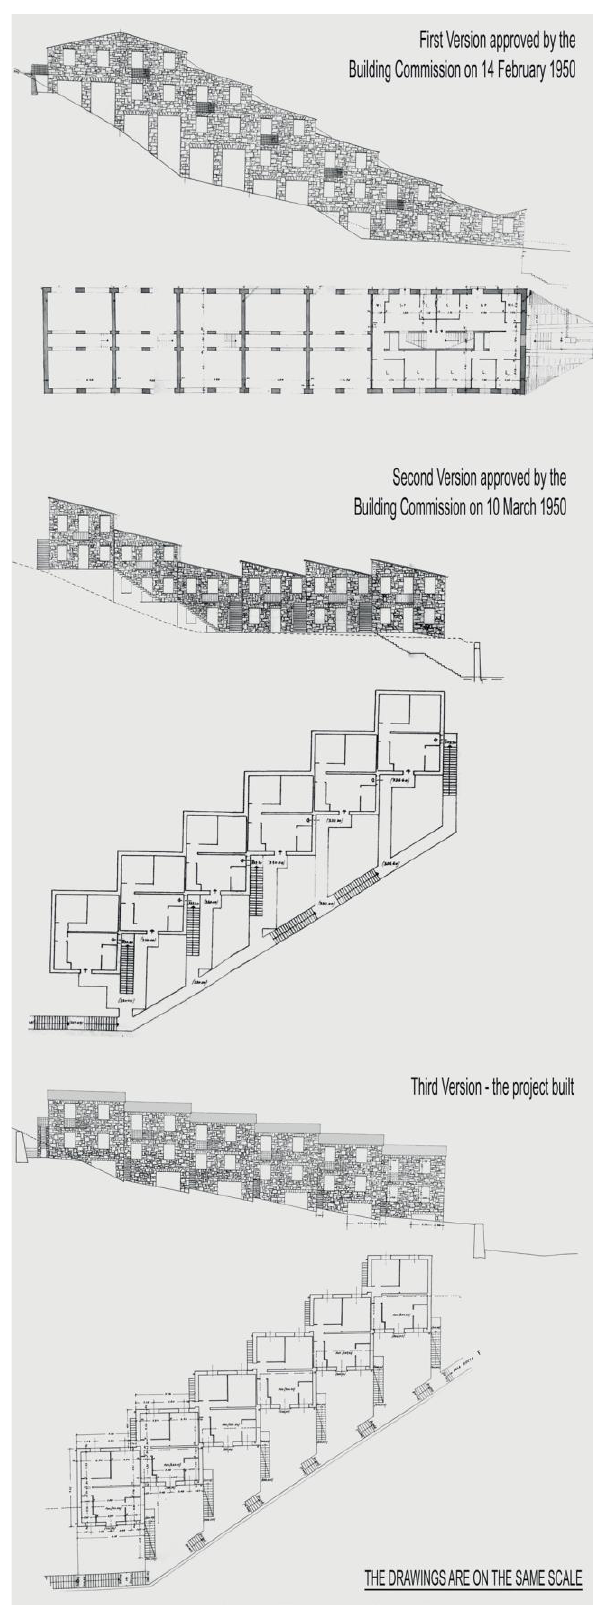
Figure 7. The three versions of the project: a) the first version approved by the Building Commission on 14 February 1950 (top) - b) the second version - after the changes requested by Ente Gestione Ina-Casa in Rome - approved by the Building Commission on 10 March 1950 (middle) - c) the third version after the variants to reduce construction costs (down).